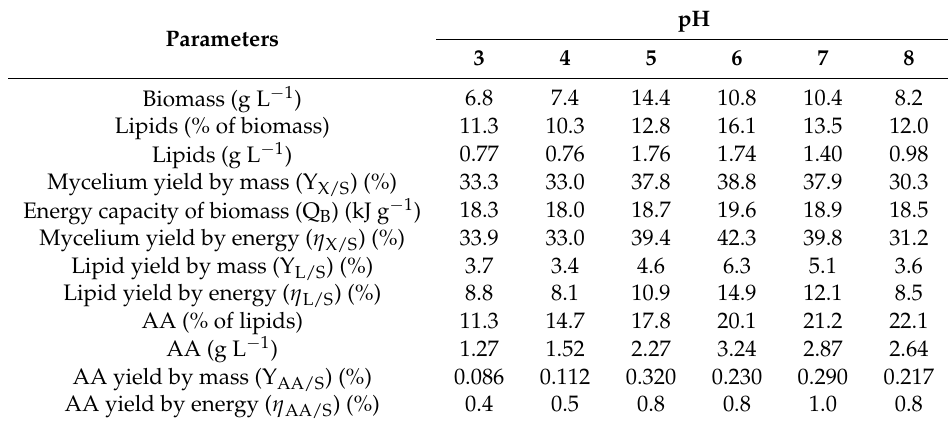
Table 1. The effect of pH on the yields of biomass, lipids, and arachidonic acid in M. alpina NRRL-A- 10995 in the exponential growth